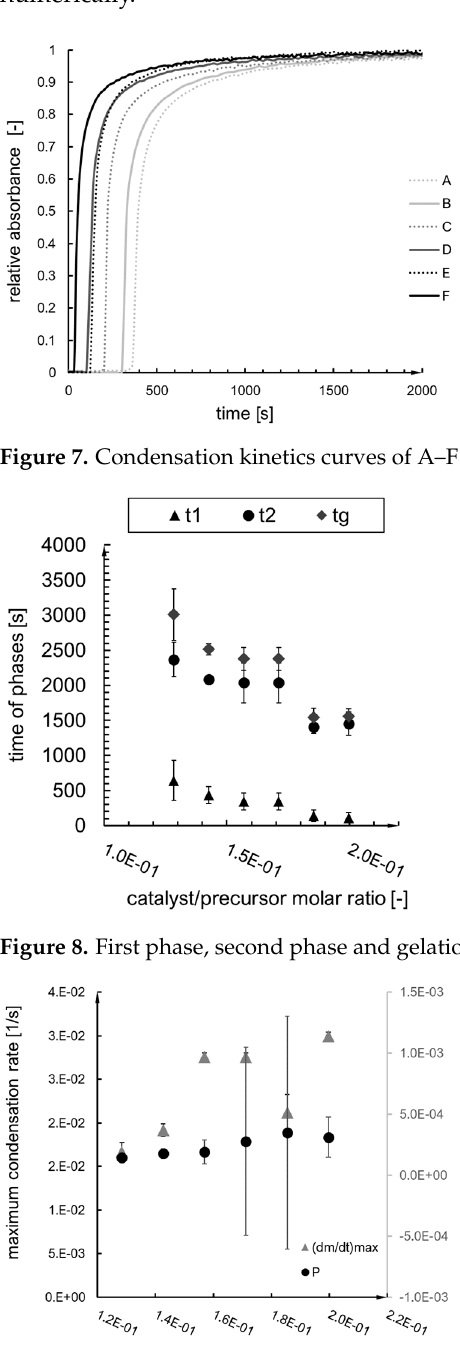
Figure 9. Dependence of probability and maximum condensation rate ( dm / dt ) max on base/precursor molar ratio.